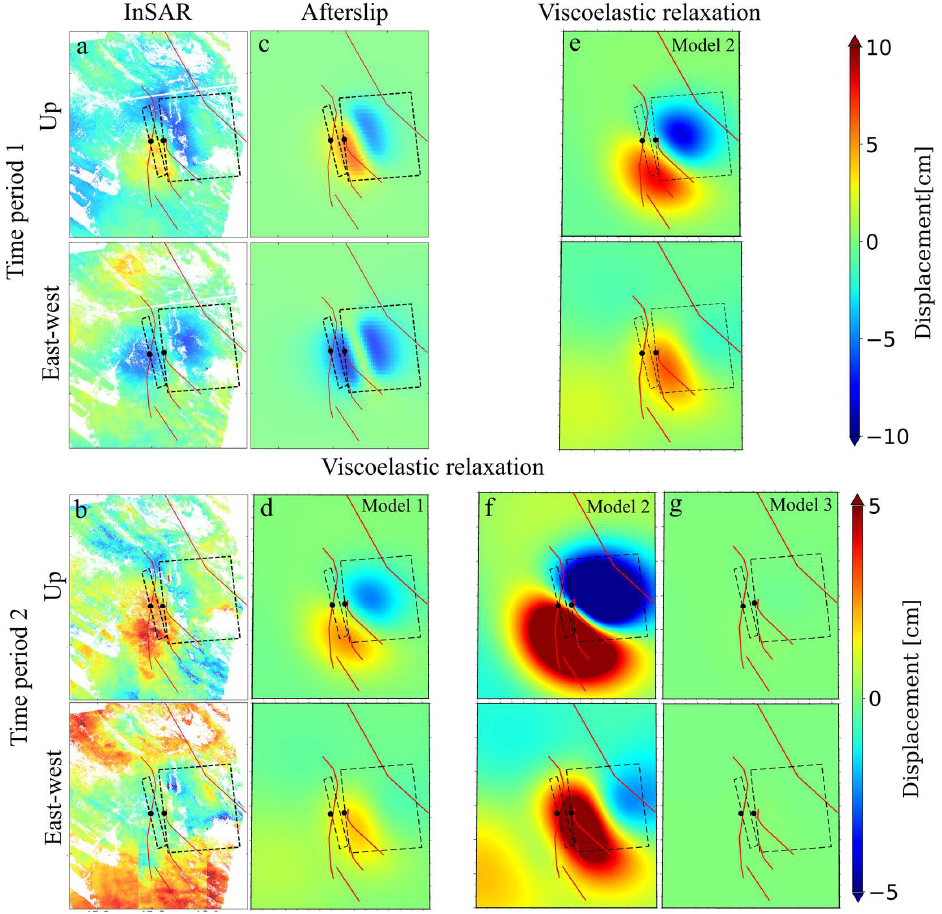
Figure 6. InSAR-derived horizontal east–west and vertical displacements with aftershocks’ contribution removed and modelling results. ( a ) and ( b ) InSAR observation; ( c ) afterslip model; ( d ) viscoelastic relaxation model 1; ( e ) and ( f ) viscoelastic relaxation model 2; ( g ) viscoelastic relaxation model 3. Black dot: upper edge of the fault. Red line: nearby faults. Thin dashed rectangle: best-fitting afterslip dislocation and coseismic fault, respectively.